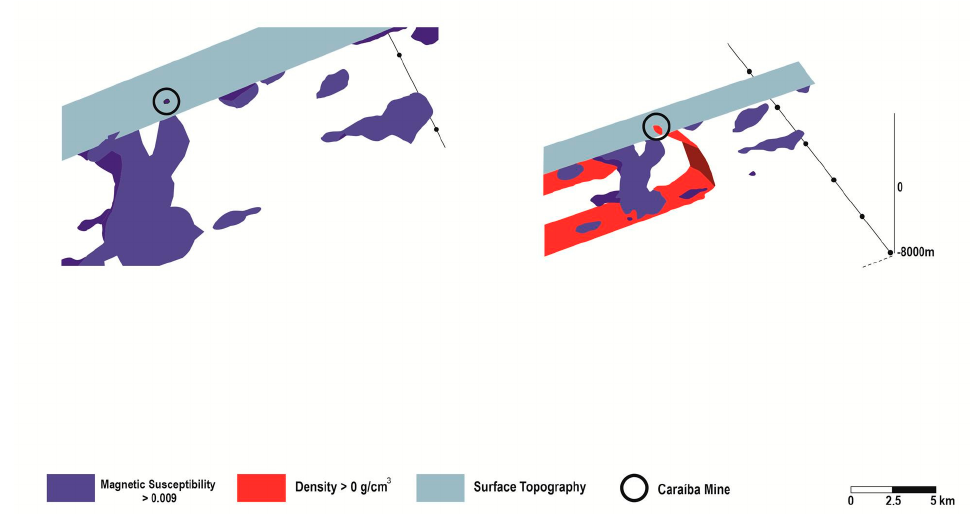
Figure 10. 3D representation of the results from magnetic (susceptibility in terms of > 0.009 SI) and gravimetric (density > 0 g / cm 3 ) inversion integrated for the Cara í ba mine. The Cara í ba mine is strongly related to susceptibility and density anomalies. It shows potential for continuity in depth in ore zones related to susceptibility and density anomalies along shear traps.